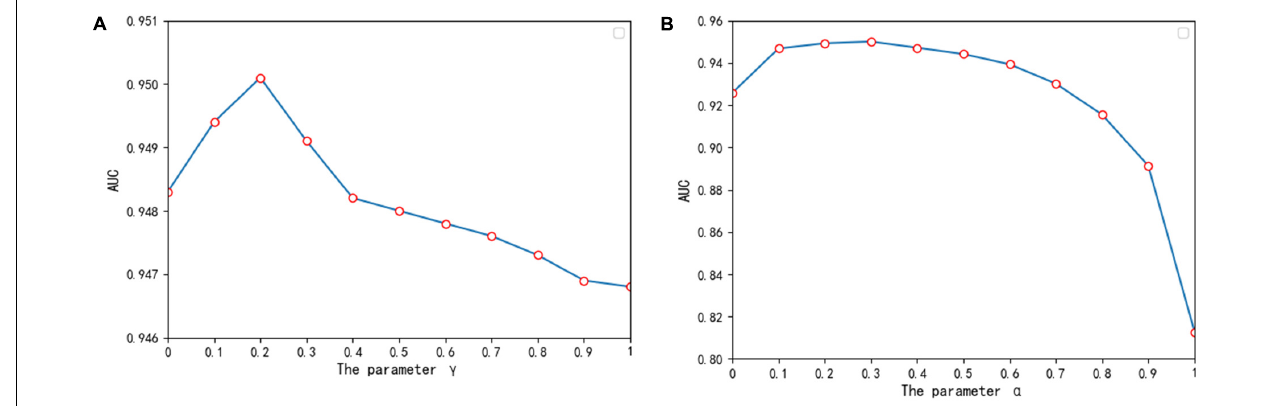
FIGURE 3 | The influence of different parameters on ILPMDA. (A) The influence of parameter γ . (B) The influence of parameter α .